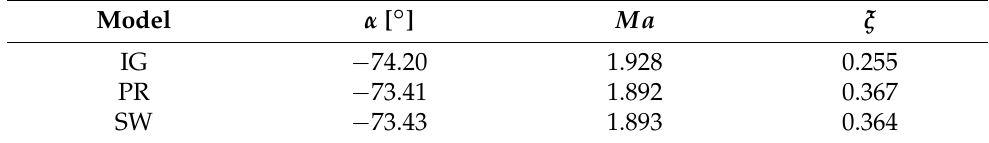
Figure 6. ORC nozzle. Pressure coefficient ( left ) and non-dimensional wall shear stress ( right ) distributions along the blade profile. Colonna et al. [6] 2D Euler, dG P 2 RANS PR EoS, dG P 2 RANS SW EoS. dG − − Table 5. ORC nozzle. Mixed-out values of the flow angle, Mach number, and total pressure loss coefficient with various thermodynamic models, P 2 solution